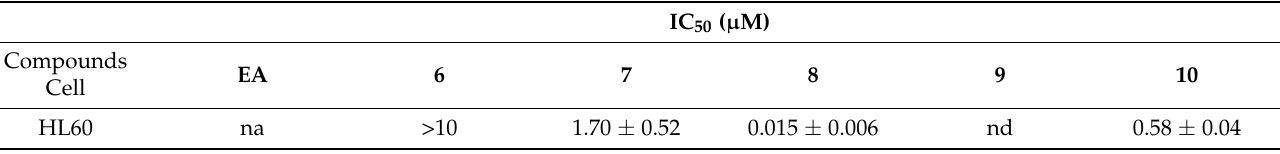
Table 1. Antiproliferative activity of EA derivatives against cancer cell line HL60 expressed in terms of IC 50 ( μ M).